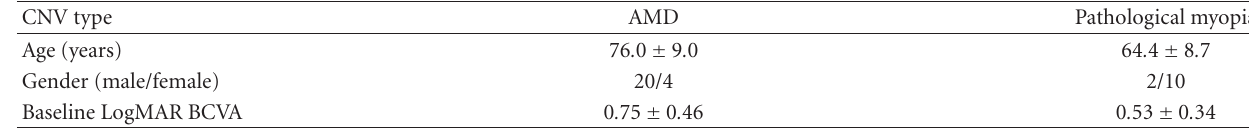
Table 1: Clinical data of CNV patients treated by oral bisphosphonate.